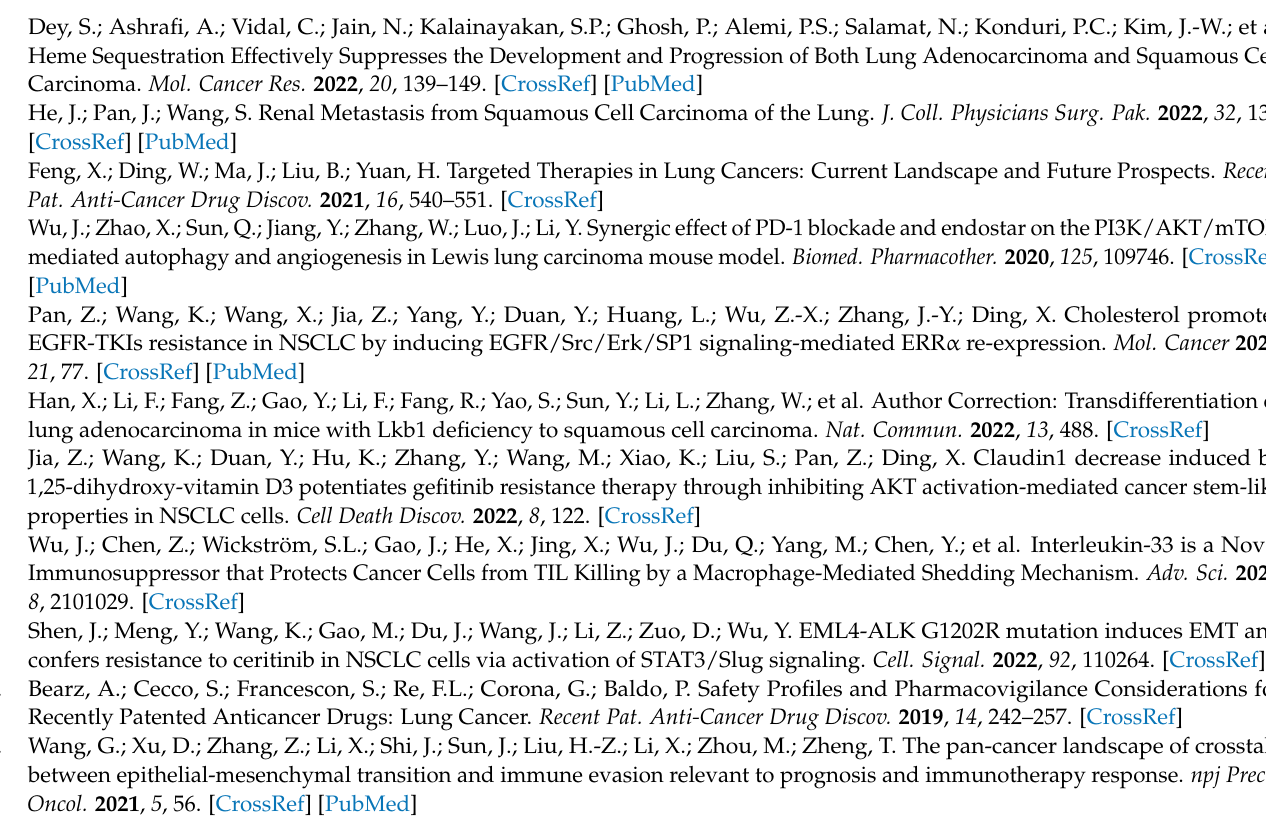
Table S9. ALL.TF.degs.sig.tet; Table S10.